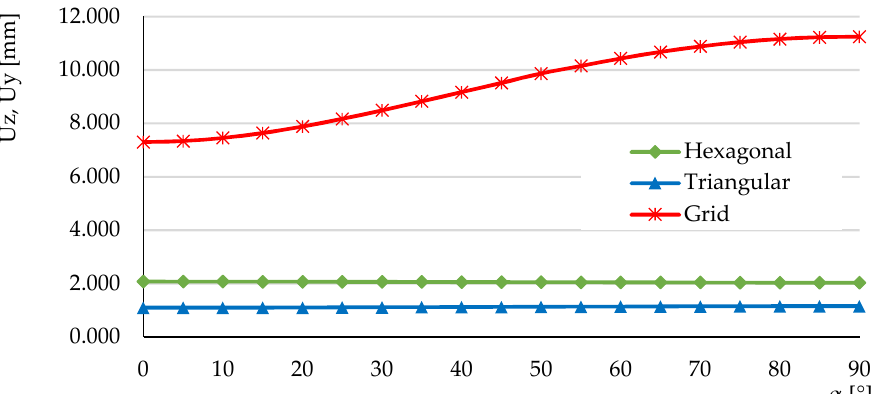
Figure 25. The influence of force orientation on the resultant displacement at asymmetric bending, 𝑈𝑟𝑒𝑠 = 𝑓(𝛼) .